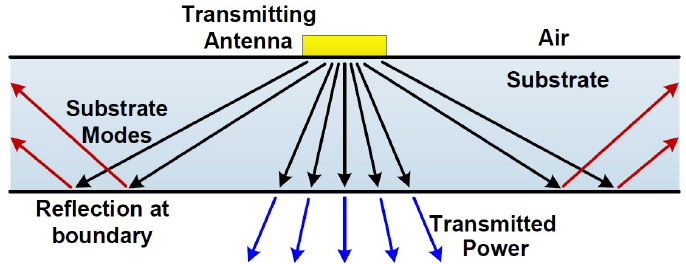
Figure 8. Ray illustration of trapped surface waves excitation in a